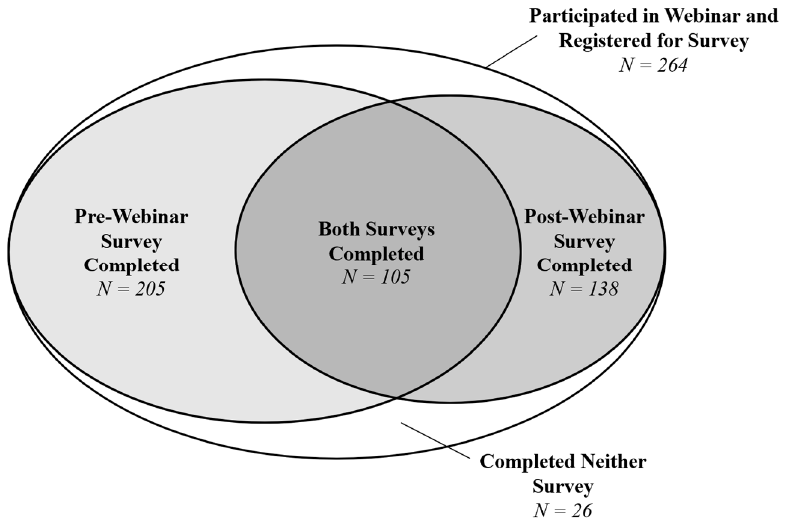
Figure 1. Number of participants who completed the pre-webinar and/or post-webinar surveys. The characteristics of the three cohorts who completed the pre-webinar, post-webinar, or both surveys are described in Table 1. The characteristics among the cohorts were broadly similar; however, there was a higher percentage of people in the post-webinar cohort who preferred not to answer demographic questions. In general, respondents had personal connections to cancer and were older, White, female, educated, and affluent. Table 1. Characteristics of webinar participants who completed surveys. Three overlapping cohorts of people (238 unique individuals) completed surveys online before or after participating in a webinar on vaccines and coronavirus. A cohort of 205 people completed the pre-webinar survey, 105 people completed both surveys, and a cohort of 138 people completed the post-webinar survey. The characteristics of race, health insurance, and connections to cancer add up to more than 100% because respondents were allowed to choose more than one answer. For other characteristics, the total may not equal 100% because of rounding.